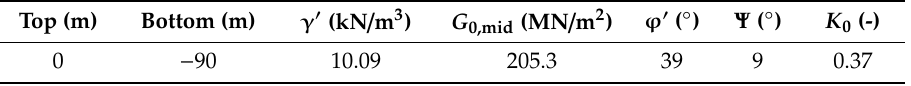
Figure 1. Triaxial test results for HSsmall model in comparison with PISA (Pile Soil Analysis) data, digitized from [9]. Table 1. Soil profile, as defined in the monopile designer, representing Dunkirk sand with D r =